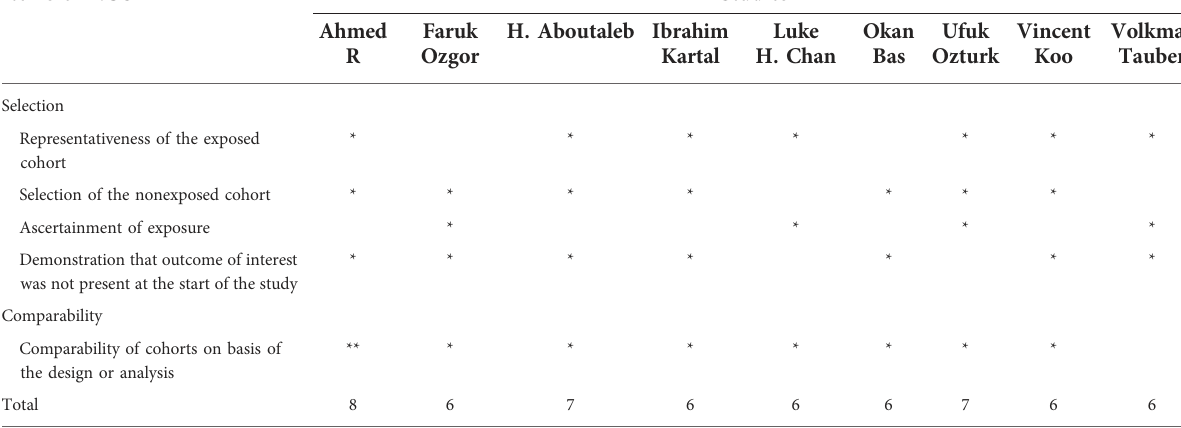
TABLE 2 Detailed quality assessment of cohort